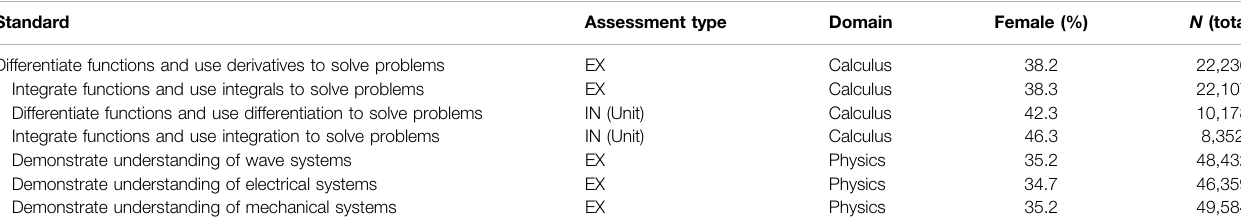
TABLE 1 | Calculus and Physics Standard Enrolments by